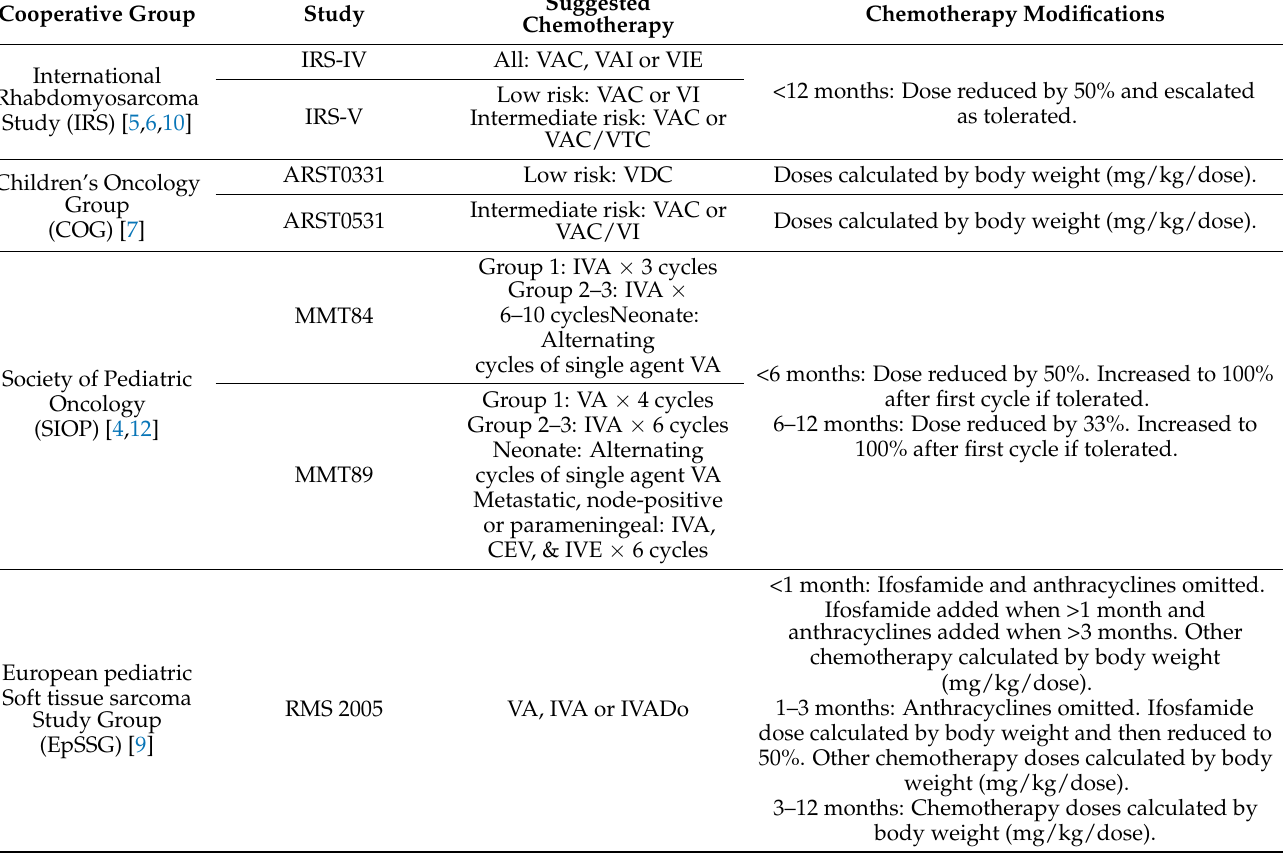
Table 2. Frontline chemotherapy regimens and dose modifications for infants under one year of age with non-metastatic rhabdomyosarcoma in clinical